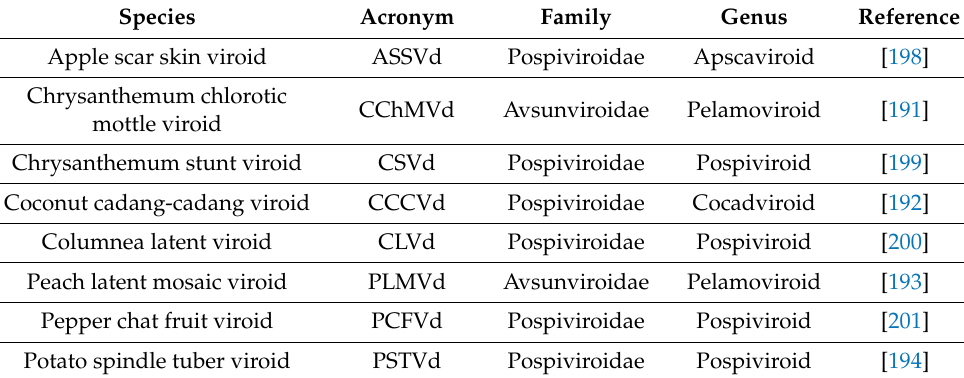
Table 3. Viroid species for which RT-LAMP protocols were developed. (Adapted from Panno et al. 2020